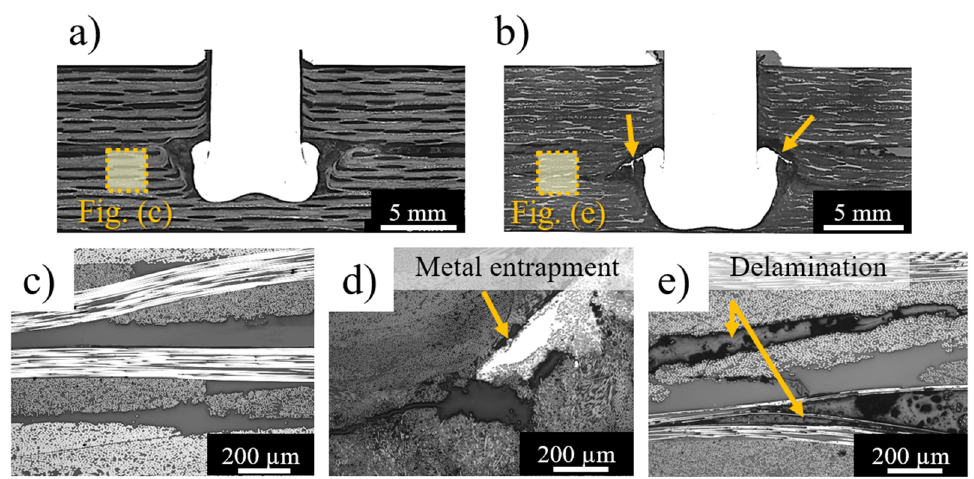
Figure 14. Typical cross-section of joints produced with ( a ) low (CP = 0.2 MPa) and ( b ) high (CP = 0.6 MPa) clamping pressures. ( c ) Detail of the lower composite part where delamination was absent for low CP joints. ( d ) Plasticized metal entrapped between fiber bundles. ( e ) Detail of process-related delamination on the lower composite part for high CP joints. (Joining parameters—RS: 15,000 rpm, DF: 7.5 mm, FF: 15 kN).